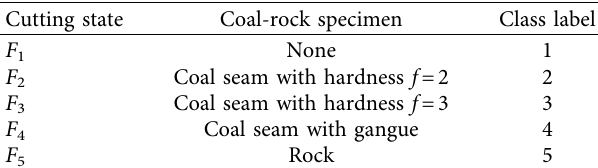
Figure 10: Four self-made typical coal-rock specimens. Table 2: The class labels of five cutting